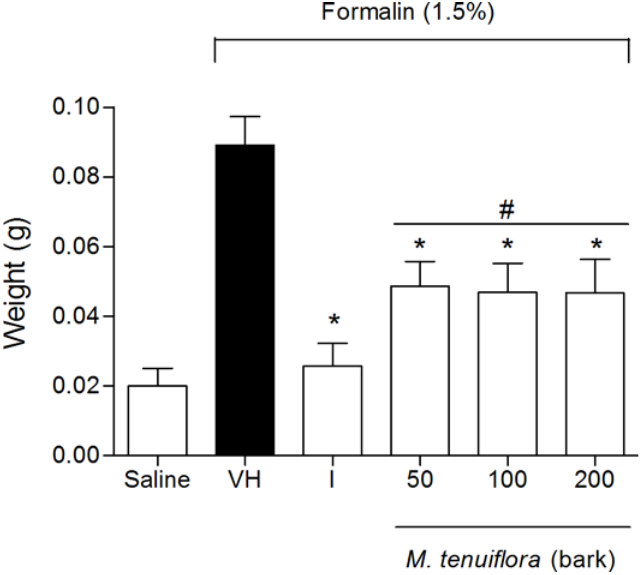
Fig 4. Effect of ethanolic extract of M . tenuiflora bark on the induction of paw edema in mice pretreated with an intraplantar injection of 1.5% formalin. VH is the vehicle group (negative control). The positive control was indomethacin (10 mg/kg, i.p.). The ethanol extract of M . tenuiflora bark was tested at doses of 50, 100 or 200 mg/kg (s.c.). The results are presented as the mean ± S.D. (n = 8). Statistical significance was calculated by ANOVA followed by Bonferroni's test. * P < 0.05 compared to the vehicle- negative control treated group. # P > 0.05 compared to the indomethacin — positive control